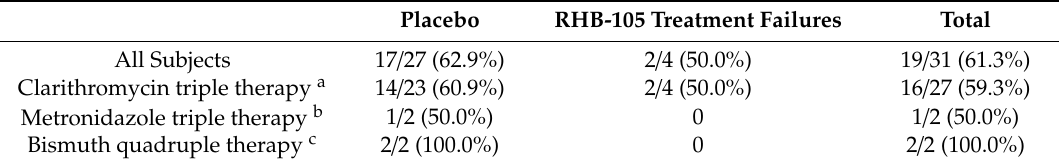
Table 3. H. pylori Eradication Rates with Physician-selected Standard-of-Care (mITT).